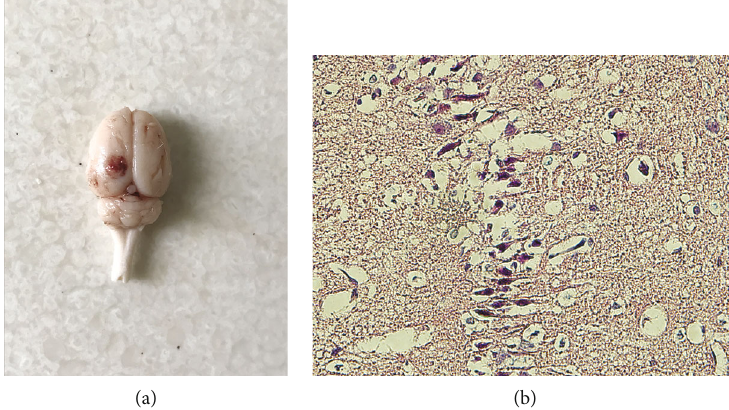
Figure 1: Whole rat brain and injured cortex image. (a) Contusion and bleeding area on the surface at the parietal and occipital brain; (b) a large number of shrink neurons with pyknosis occurred in the injured cortex. Scale bar: 50 μ